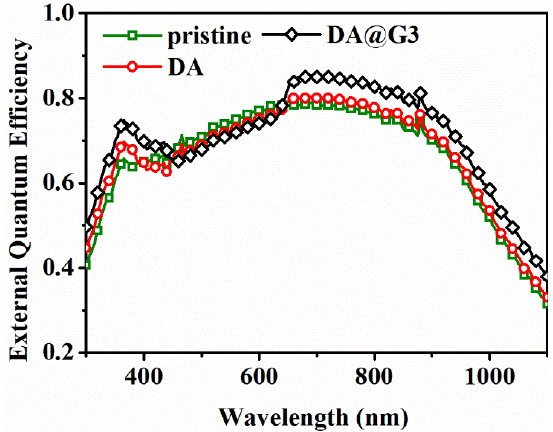
Figure 7. External quantum efficiency (EQE) spectra for solar cells without DA@G (pristine), with dopamine (DA) and with DA@G3.